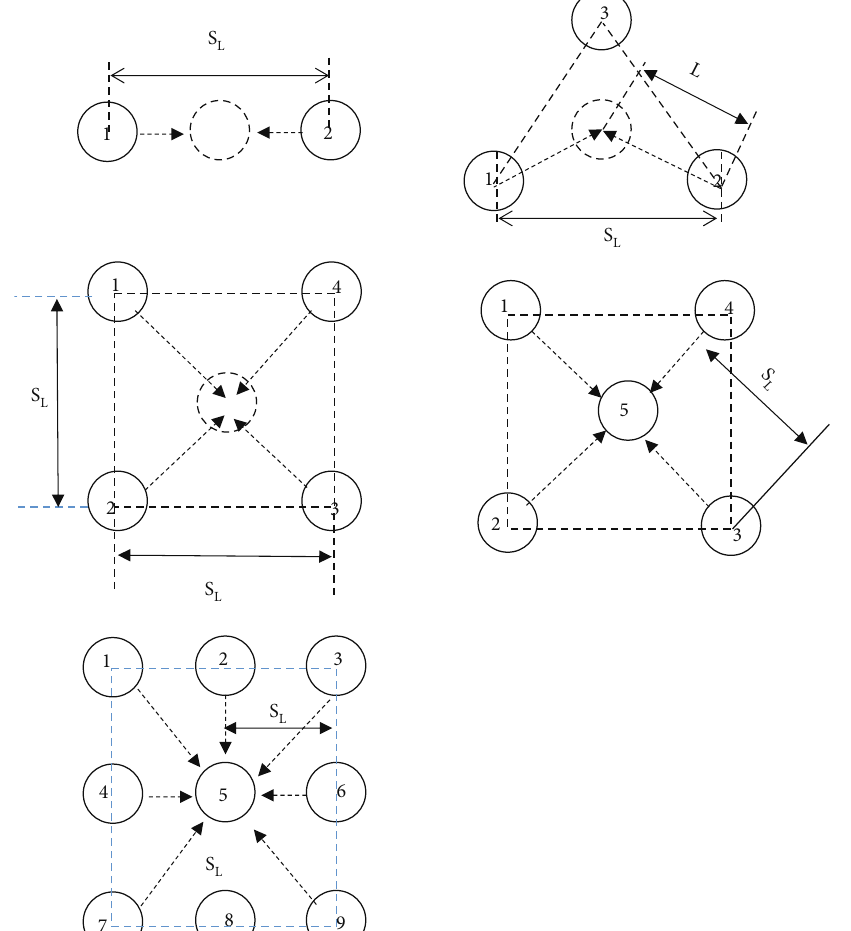
Figure 11: Con fi gurations of group